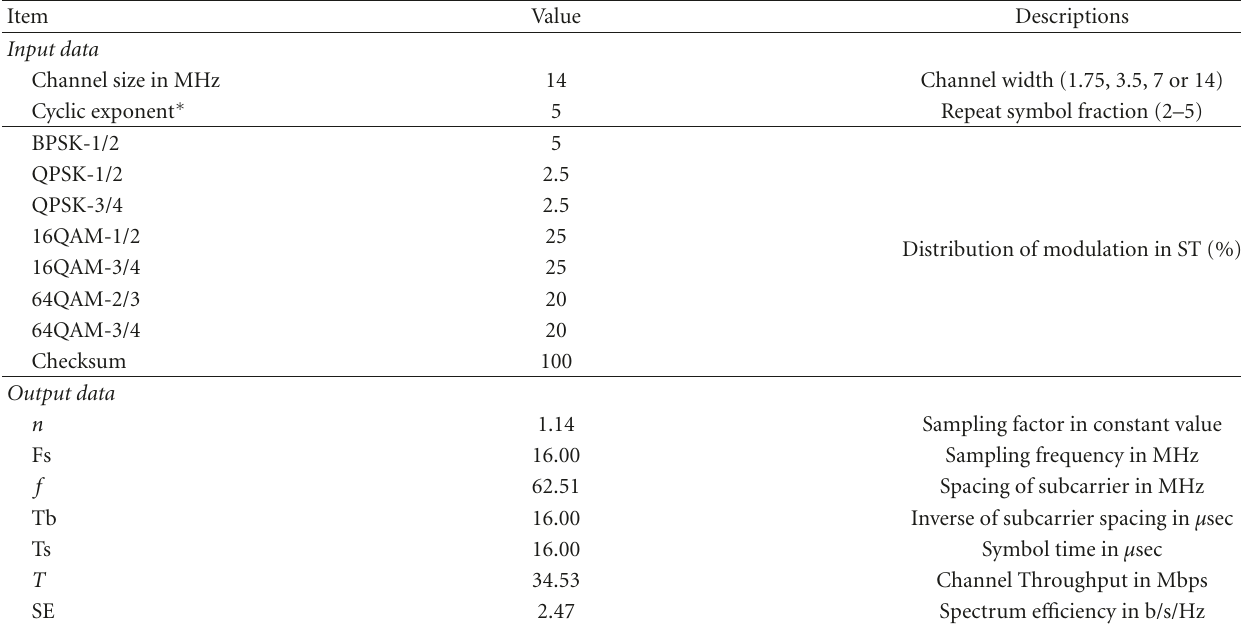
Table 5: Channel throughput calculation model.